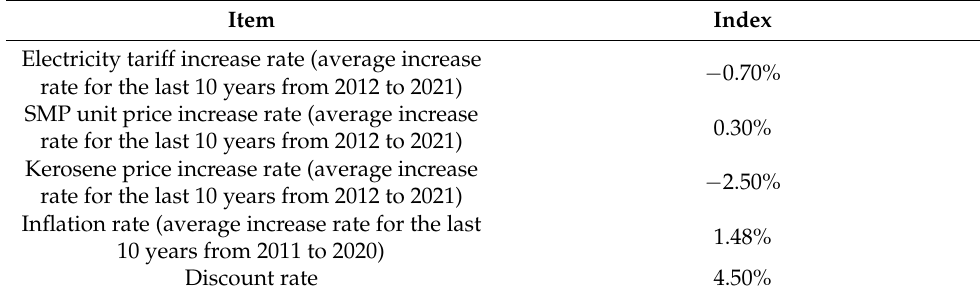
Table 6. Inflation rate index.